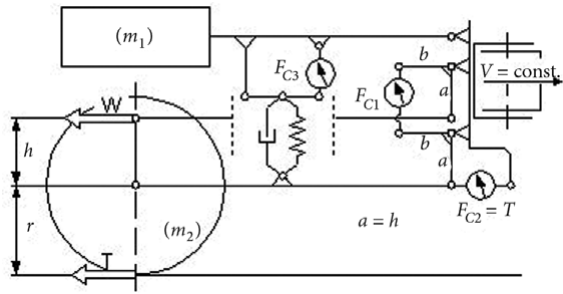
fig. 2. Kinematic scheme of the dynamometer trailer